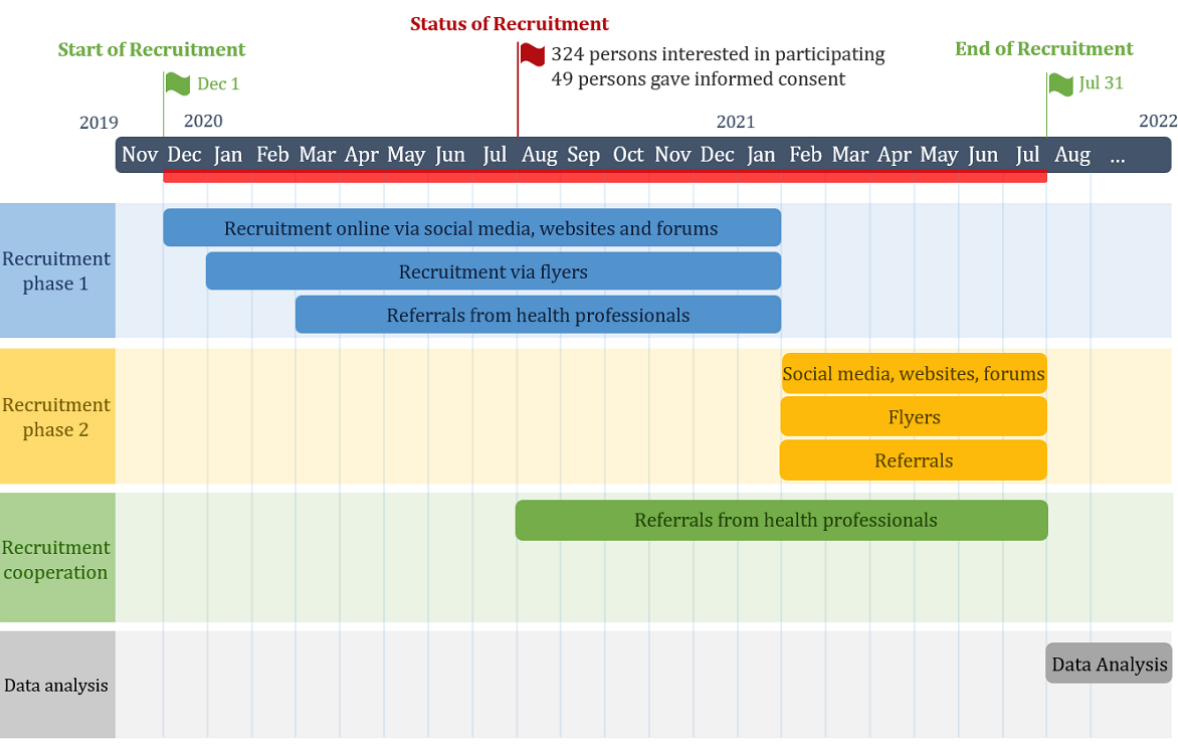
Figure 3. Gantt chart displaying the study’s recruitment schedule and status of